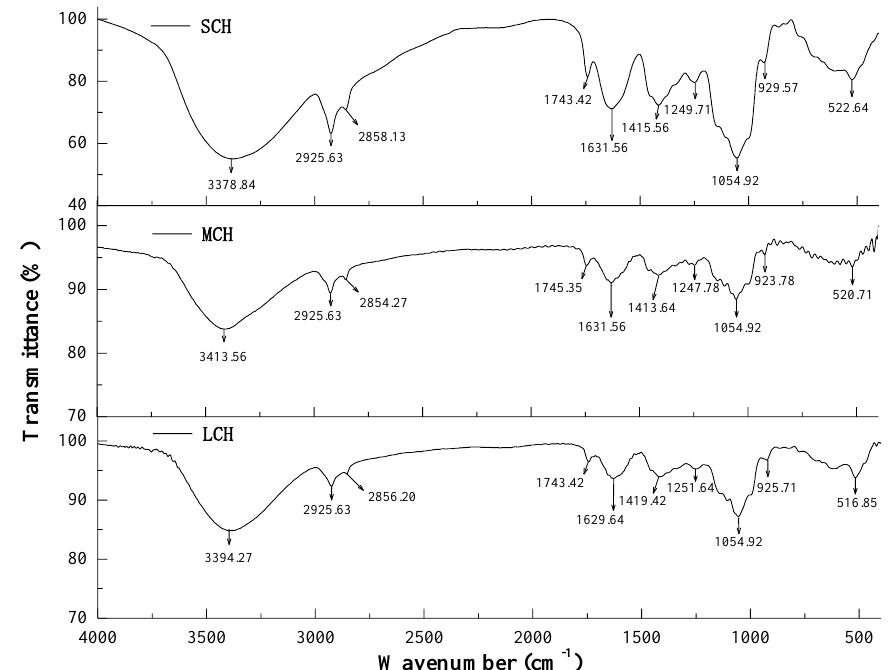
Figure 4. FTIR spectra of coconut haustorium.